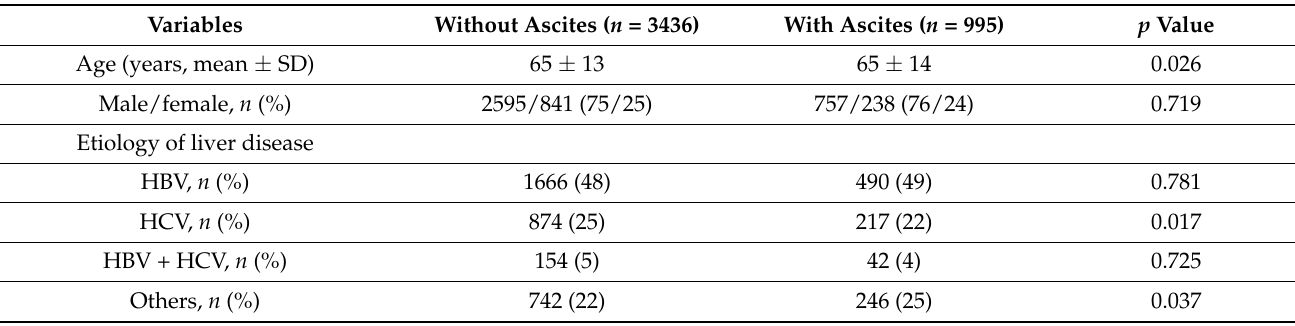
Table 1. Baseline characteristics of hepatocellular carcinoma patients with and without ascites ( n =